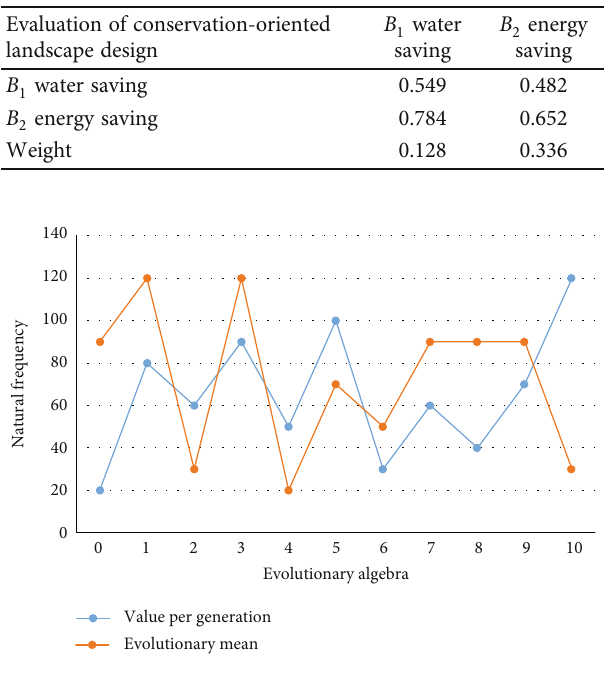
Table 1: Criteria level index judgment matrix and weight.